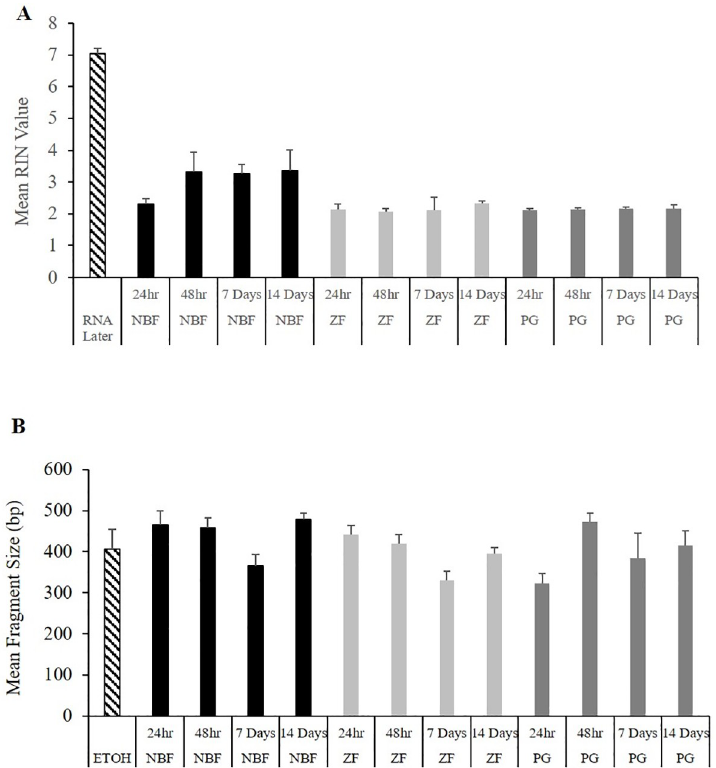
Fig 3. Nucleic acid quality. (A) Mean RIN values of RNA and (B) fragment size (bp) of DNA from samples fixed in 10% neutral buffered formalin (NBF), Z-Fix (ZF) and PAXgene (PG) for 24 hours, 48 hours, 7 and 14 days. Samples preserved in 95% alcohol (ETOH) and RNAlater were included as